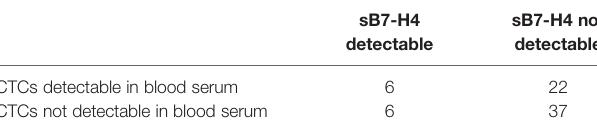
TABLE 5 | Presence of sB7-H4 and CTCs in blood serum in patients with advanced